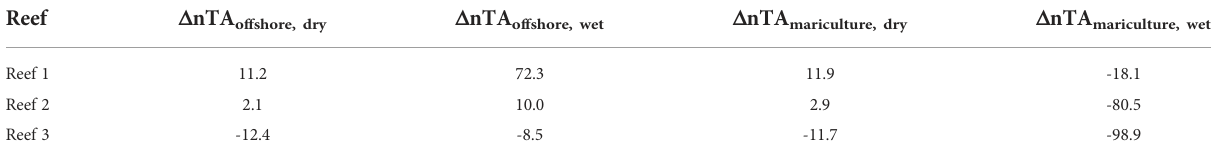
TABLE 2 Net calci fi cation potential ( D nTA in m mol kg -1 ) of each reef calculated per season and with either mariculture ( D nTA mariculture ) or offshore ( D nTA offshore ) considered as source